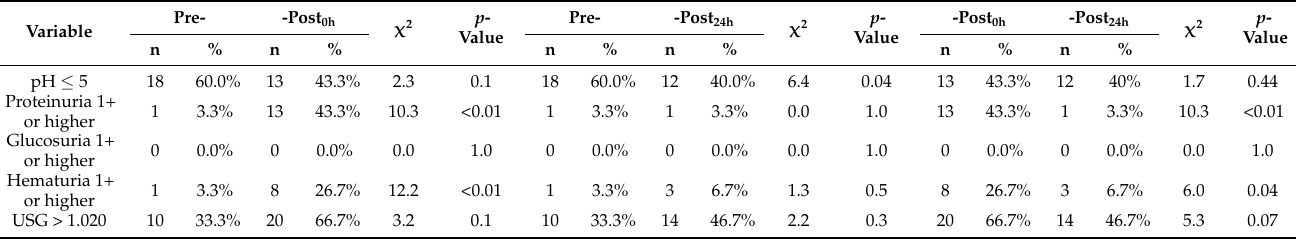
Table 2 . Distribution and pattern of change of urine dipstick readings of pH, proteinuria, glucosuria, hematuria, and USG.